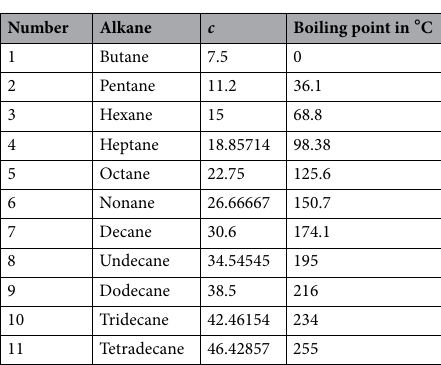
Table 3. Data for 11,